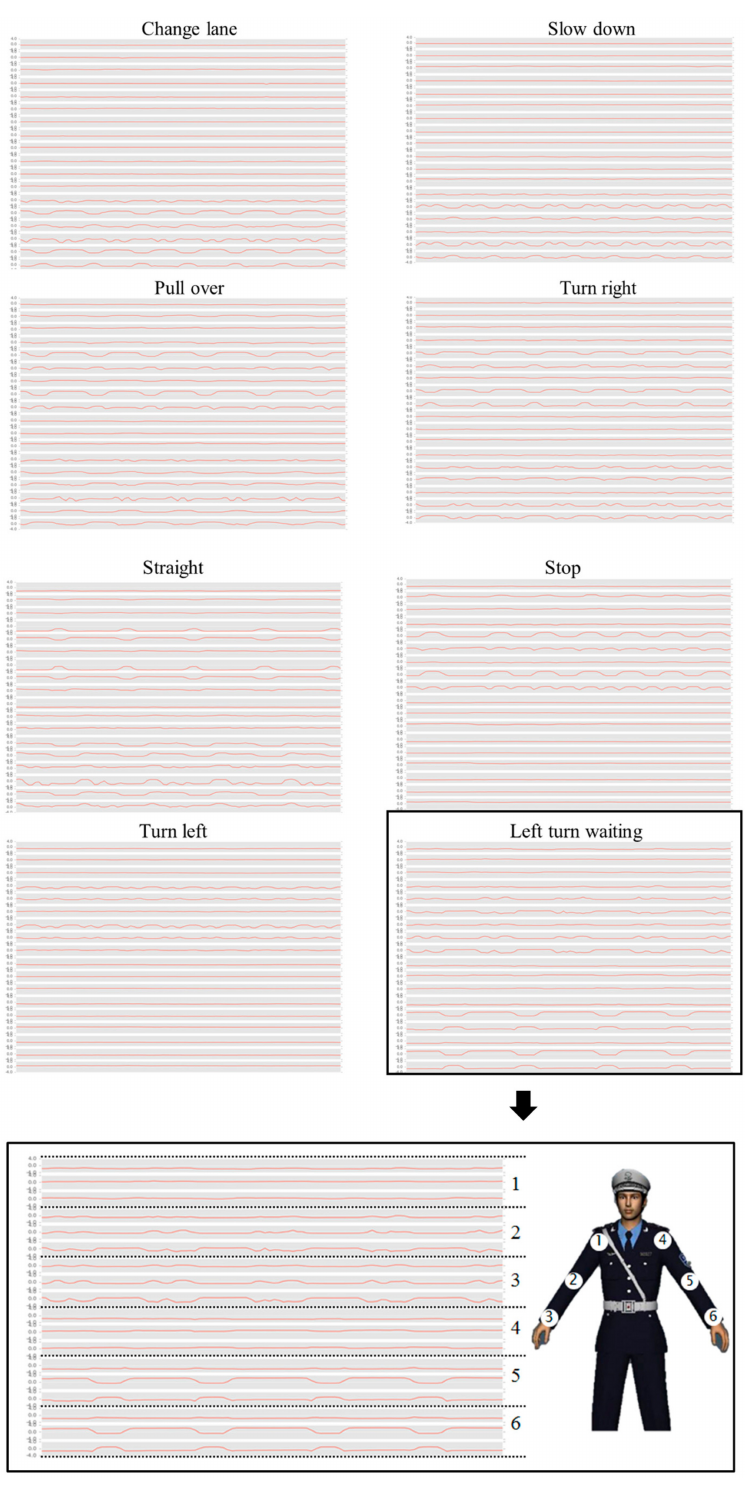
Figure 6. Input signals of the spatiotemporal convolution neural network (ST-CNN) model are visualized. The signals of eight traffic command actions are listed, respectively. Among them, the signal of left turn waiting is introduced in detail. Each three rows of signals represent a skeletal point position change, defined by xyz. Six skeletal points correspond to the right